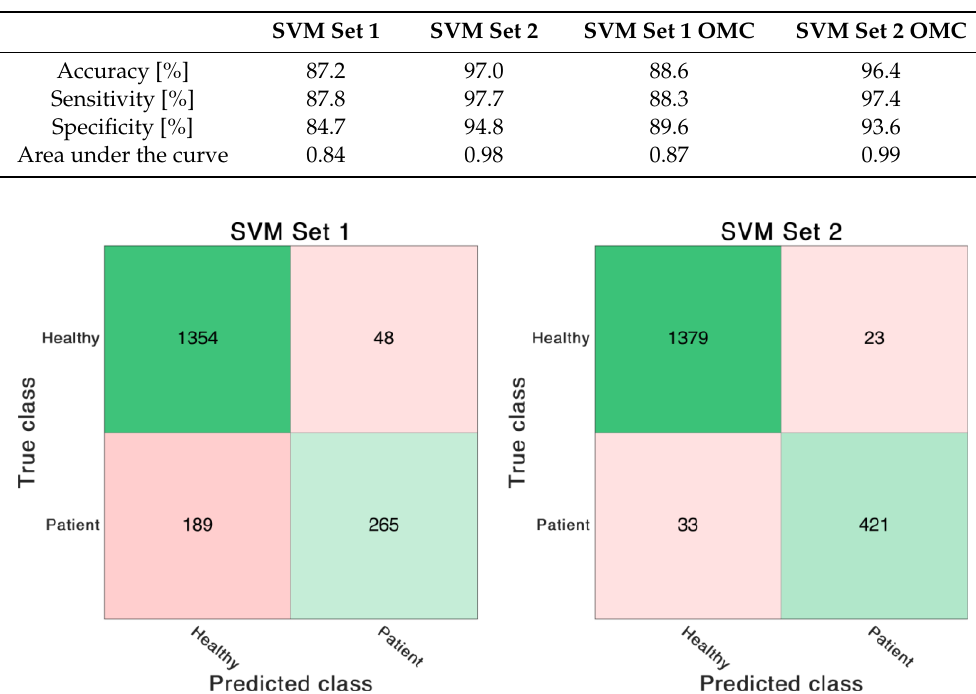
Table 6. Results of the di ff erent SVM models trained on feature Set 1 and Set 2. “OMC” indicates the support vector machine (SVM) model trained on the features calculated based on the optical motion capture system.